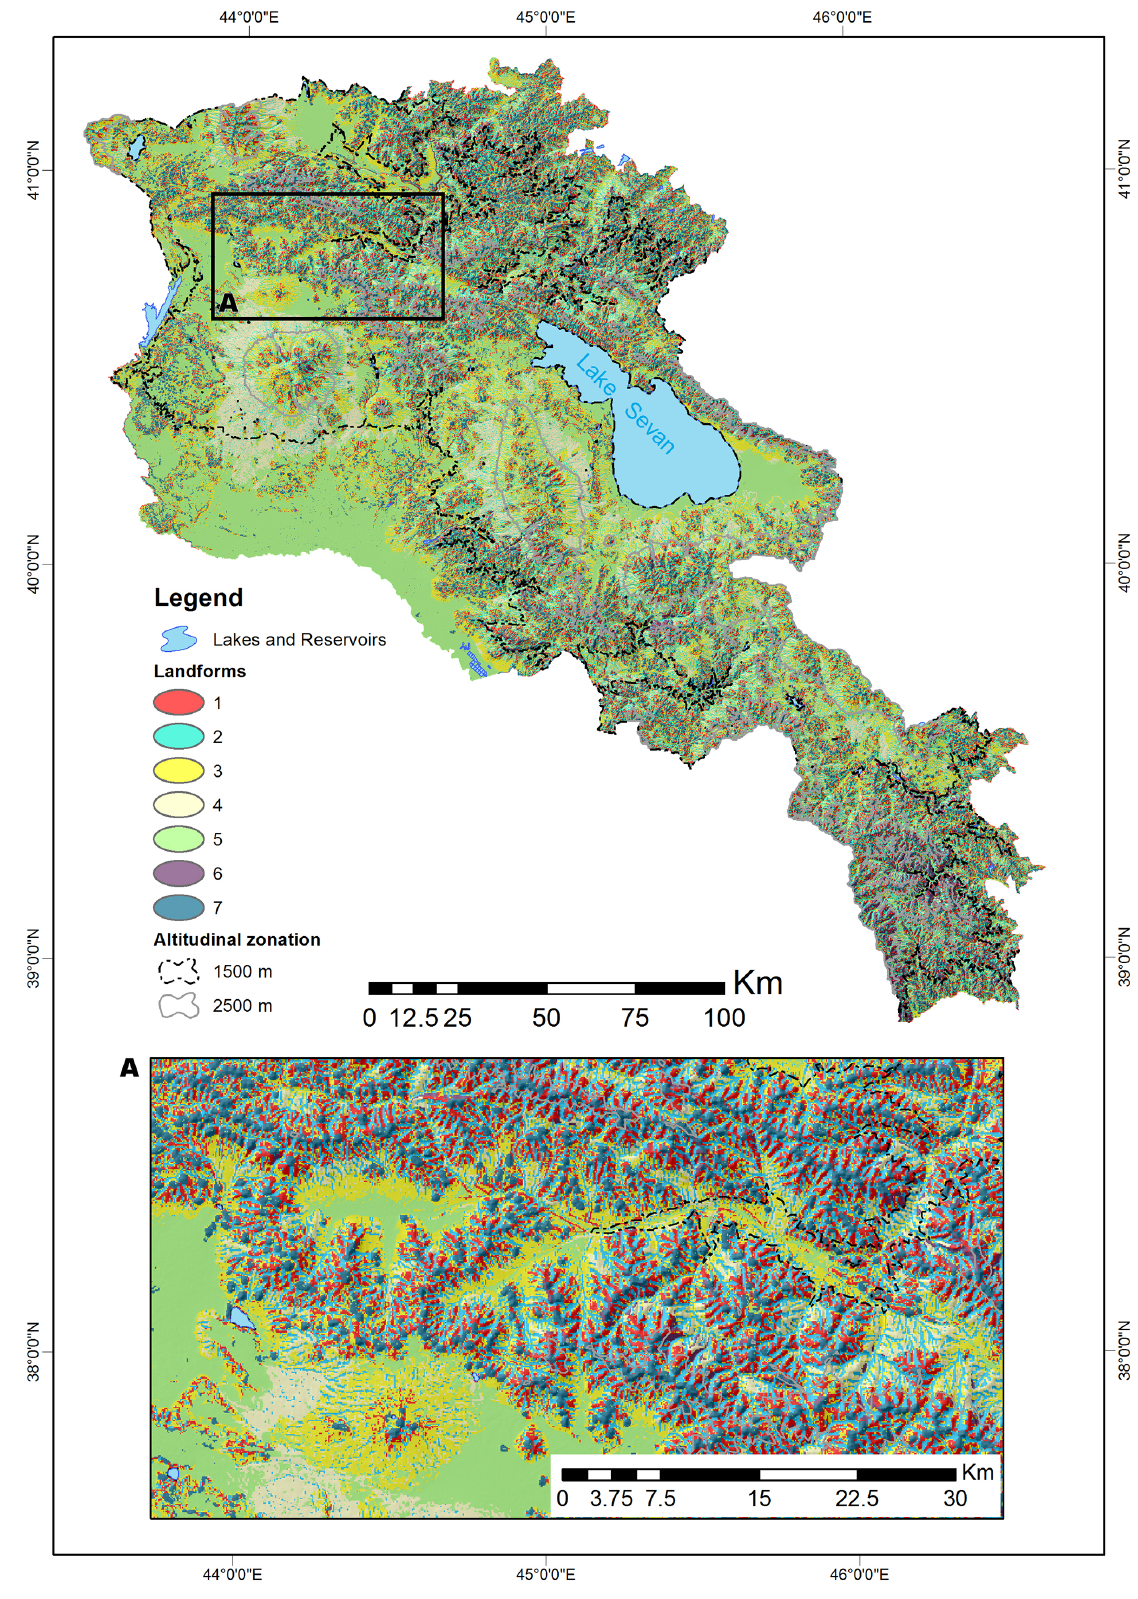
Fig. 5. Map of landforms in